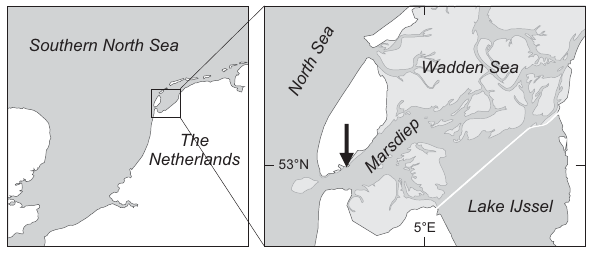
Fig. 1. Map of the southeastern North Sea and Wadden Sea; the arrow marks the sampling site at the entrance of the Marsdiep tidal